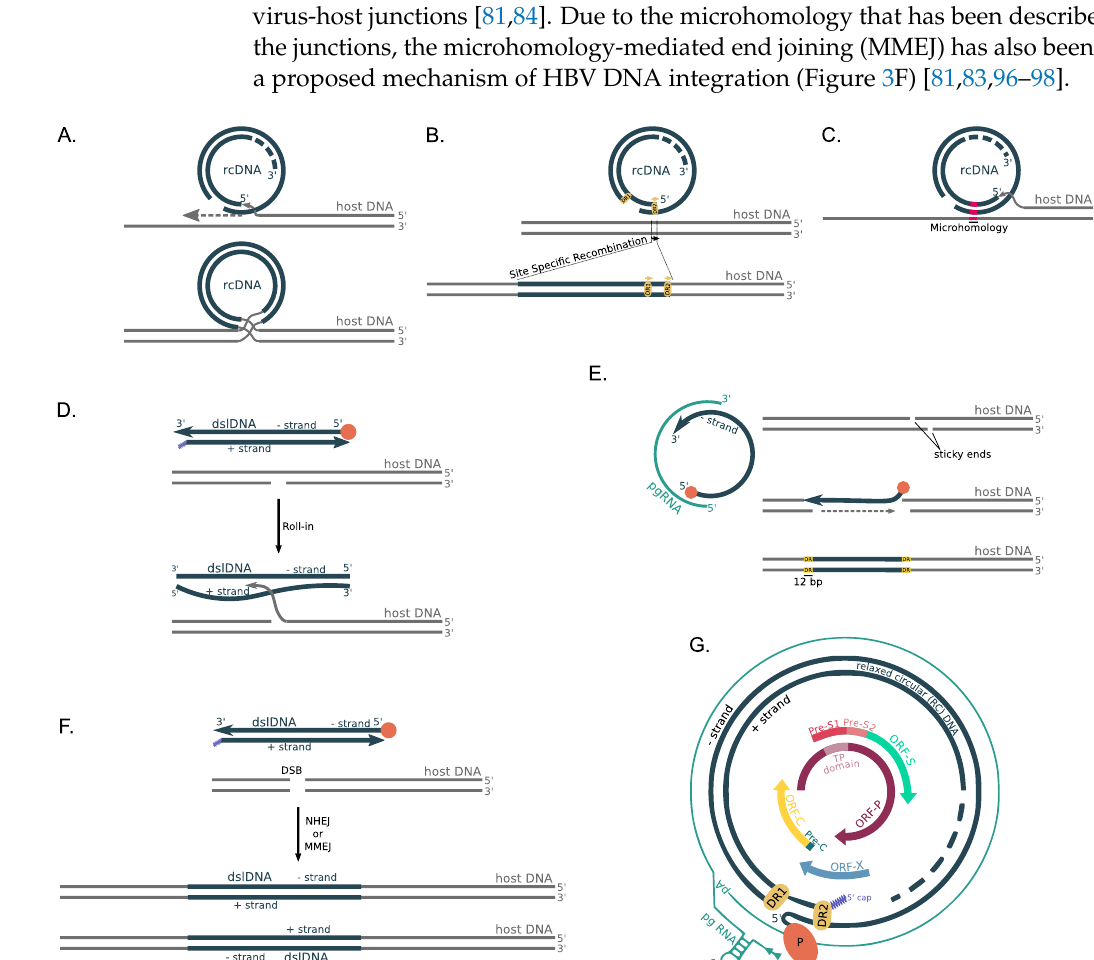
Figure 3. The molecular mechanisms of HBV DNA integration into the host genome with respect to the relaxed circular DNA (rcDNA) and double-stranded linear DNA (dslDNA) structure. ( A ) The ‘single-stranded-gap’ model [11], implies that the DNA polymerase switches from the human genomic DNA strand to the 5 (cid:48) single-stranded region of the nearby HBV genome, followed by a recombination event. ( B ) The HBV ‘DR-mediated integration’ model [86] implies that HBV DNA integration occurs via a site-specific recombination event between host genomic DNA and either in DR1 or DR2. ( C ) The ‘partial-sequence homology’ model [90] implies that a microhomology between the host DNA and the HBV genome triggers the switch of the DNA polymerase from the host DNA to the single-stranded region of the HBV rcDNA, which is followed by a recombination event in the site of the microhomology that determines the site of integration. ( D ) The ‘roll-in’ model [14] is based on HBV dslDNA where the free end at a single-strand break in cellular DNA invades into the HBV genome and forms the host–viral junction. ( E ) The minus strand of the HBV rcDNA is released from the replication complex before HBcAg synthesis, while a staggered break at the host DNA leaves sticky ends in which the incomplete HBV genome is inserted, resulting in the formation of 12 bp DRs that are neither viral nor cellular on either side of the viral integration site [93]. ( F ) The ‘NNEJ/MMEJ-based model’ implies that the HBV dslDNA is integrated at a site of DSB after its repair and removal of the Pol protein and the 5 (cid:48) cap via Non-Homologous End Joining in both directions or via Microhomology-Mediated End Joining in a direction determined based on the microhomology. ( G ) The relaxed-circular HBV DNA structure and genome organization. The inner region depicts the organization of the HBV genes, the dashed blue circle represents the (+) strand, the solid blue circle represents the ( − ) strand and the outer petrol-blue line represents the HBV